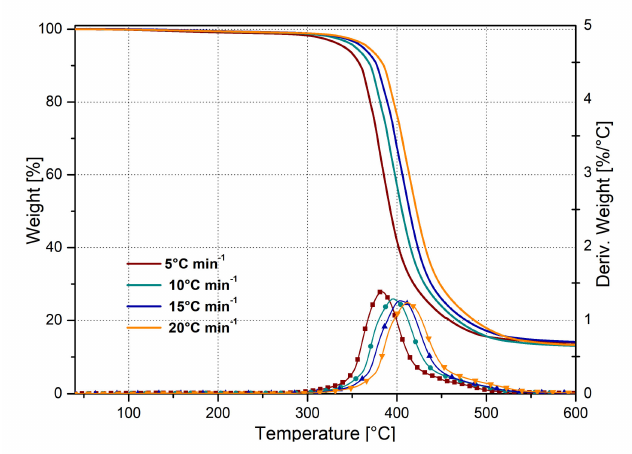
Figure 5. TGA curves of neat epoxy matrix at di ff erent heating